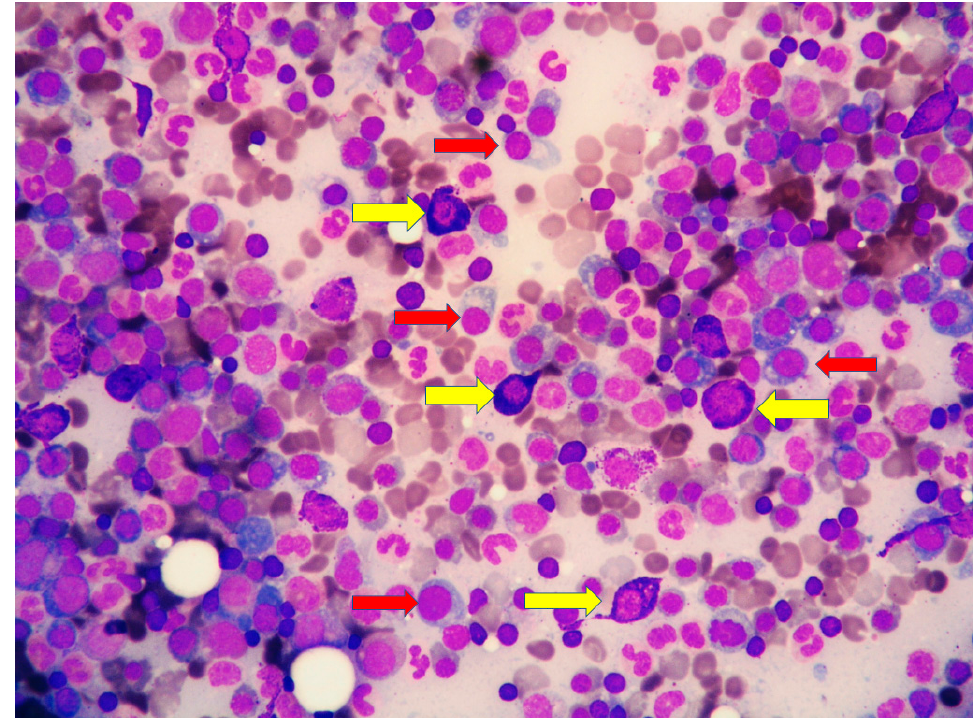
Figure 5. High magnification of marrow aspirate disclosing the two neoplastic components: (i) mast cells with basophilic granular cytoplasm (yellow arrows) and (ii) plasma cells with eccentric nucleus (red arrow).